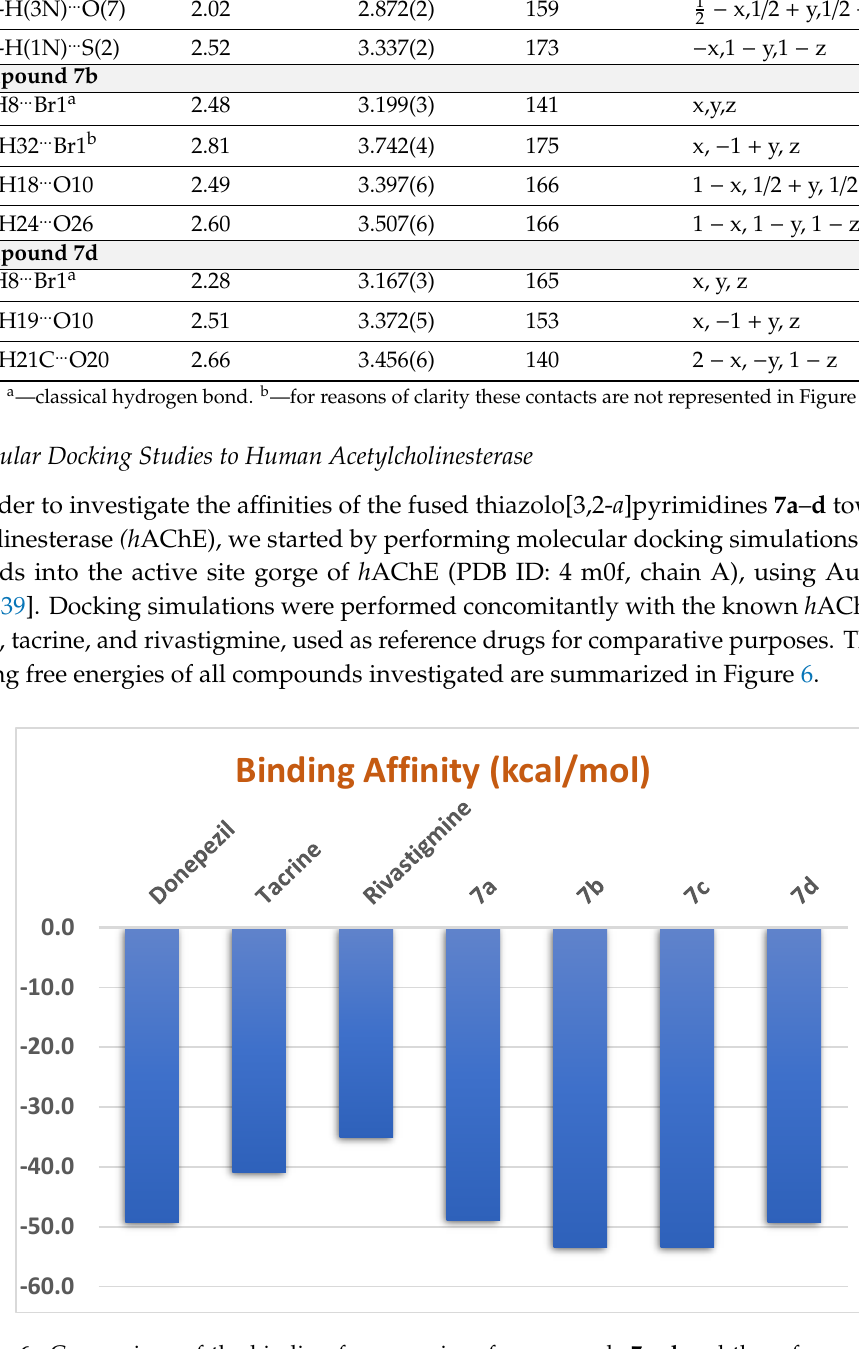
Table 5. Interaction parameters for compounds 4a , 7b , and 7d.